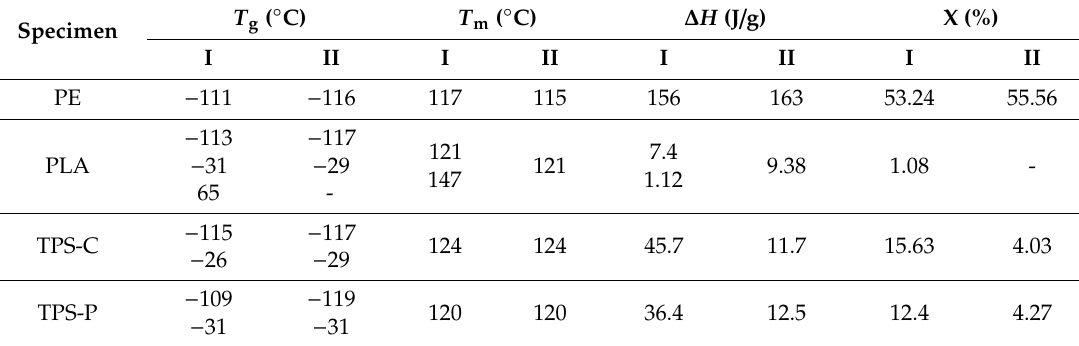
Figure 1. DSC curves of tested granulates. Table 2. DSC measurement results for